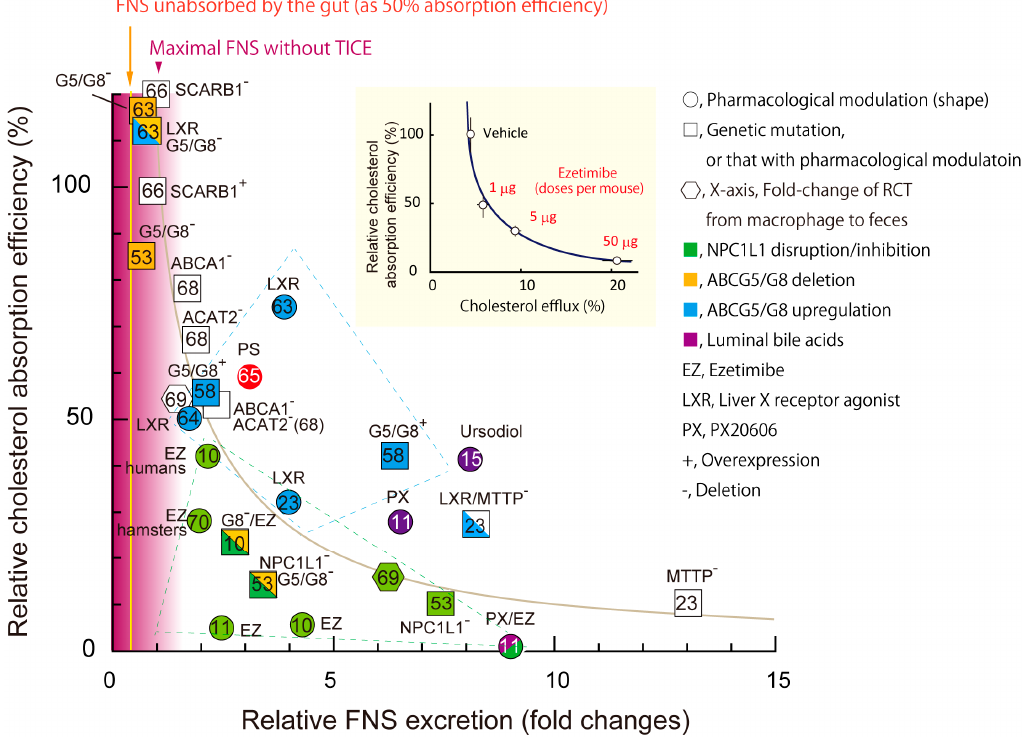
Figure 3. The relationship between intestinal cholesterol absorption and fecal neutral sterol (FNS) excretion. Inset , the figure was originally published in Nakano, T., et al. PLoS ONE 2016; 11(3) : e0152207 [54]. The original titles for the X- and Y-axis were “% of DPM appearing in the lumen/DPM in intestinal segment (Efflux efficiency)” and “Relative lumen-to-circulation 3 H-cholesterol transit (% vs. vehicle)”, respectively. The titles were changed to simplify the figure. An inverse relationship between absorption and TICE was hypothesized in the paper. The numbers (micrograms) in the figure indicate the dosages of ezetimibe given to mice. All 28 data sets presented in the figure were obtained from 13 published papers. Cholesterol absorption efficiency (%) indicates relative ratios compared with the respective control groups, for example, wild-types for transgenic mice and vehicle administration for pharmacological treatments. Circles , chemical treatments; squares , transgenic mice or those with chemical treatments; hexagonal shapes , macrophage-to-feces reverse cholesterol transport. EZ, ezetimibe, LXR, liver X receptor agonist; PX, a farnesoid X receptor agonist PX20606. +, mice with overexpression of the indicated gene(s); − , mice with deletion of the indicated gene(s). Green , NPC1L1 was disrupted by genetic deletion or by EZ treatment; yellow , genes for ABCG8 (G8) or both ABCG5 and G8 (G5/G8) were deleted; blue , ABCG5/G8 expression levels were activated by a LXR agonist or genetic modification(s). ACAT2, acyl-CoA acyltransferase 2; ABCA1, ATP-binding cassette A1; MTTP, microsomal triglyceride transfer protein; SCARB1, scavenger-receptor B1. Mice were used as the model unless mentioned otherwise in the plots. Letters in the symbols indicate the references the data were obtained from. The areas shown as blue and green dotted lines indicate experiments with LXR agonists or ABCG5/G8 overexpression, and those with EZ or NPC1L1 deletion, respectively. Yellow vertical line indicates basal FNS excretion originating from unabsorbed cholesterol as 50% absorption efficiency. Purple gradation indicates the approximate maximal FNS excretion originated from unabsorbed cholesterol